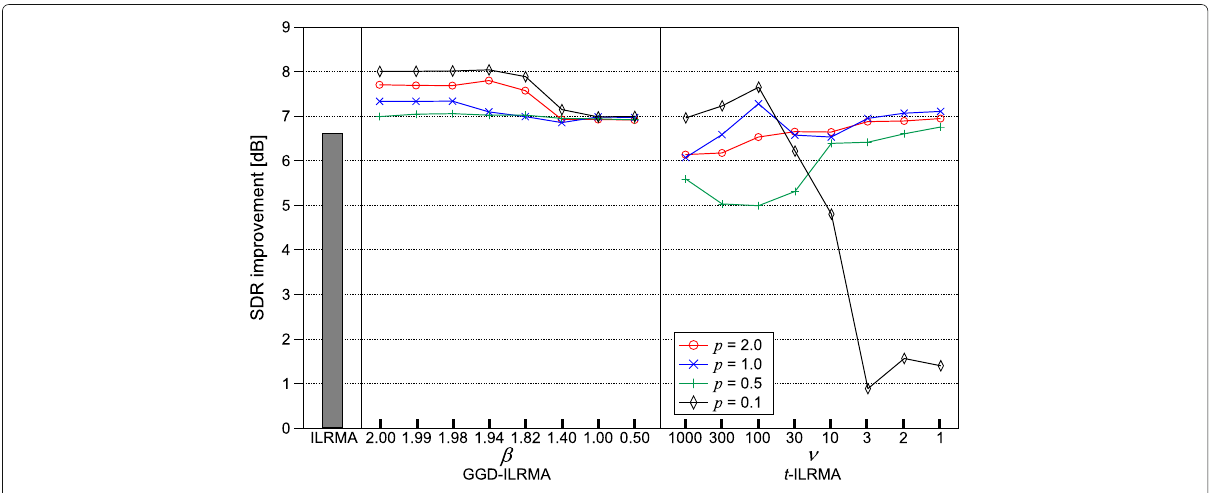
Fig. 22 Average SDR improvements of Speech 1 with E2A_2 signal using parameter tempering